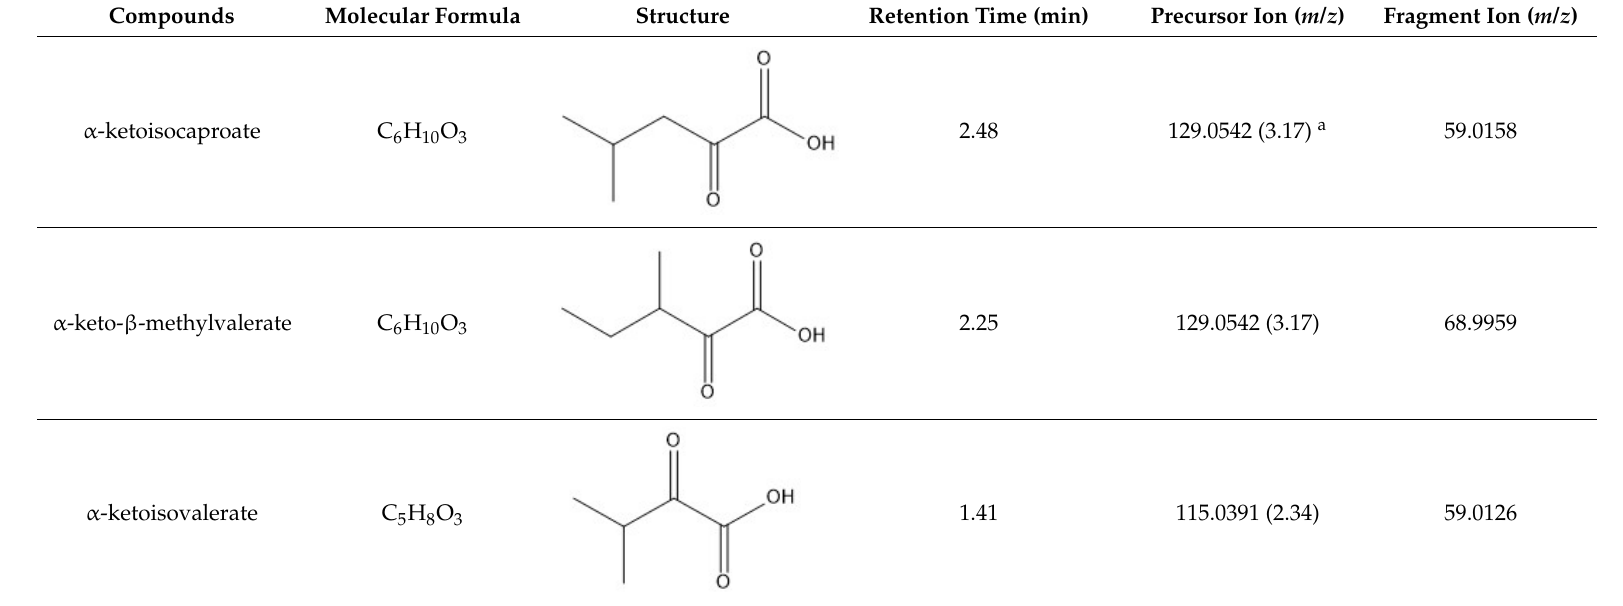
Table 1. Chemical structure and tandem mass spectrometry parameters of the branched-chain keto acids.